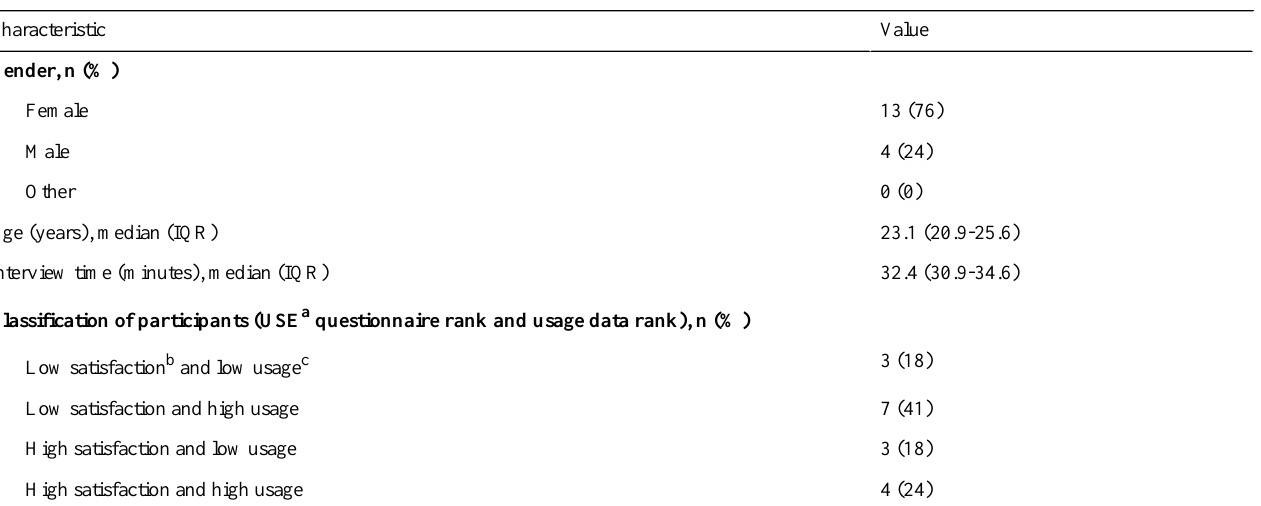
Table 1. Baseline characteristics of participants who were interviewed